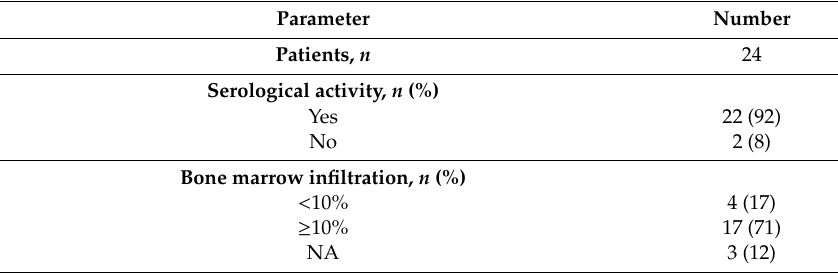
Table 2. Patterns of relapse and